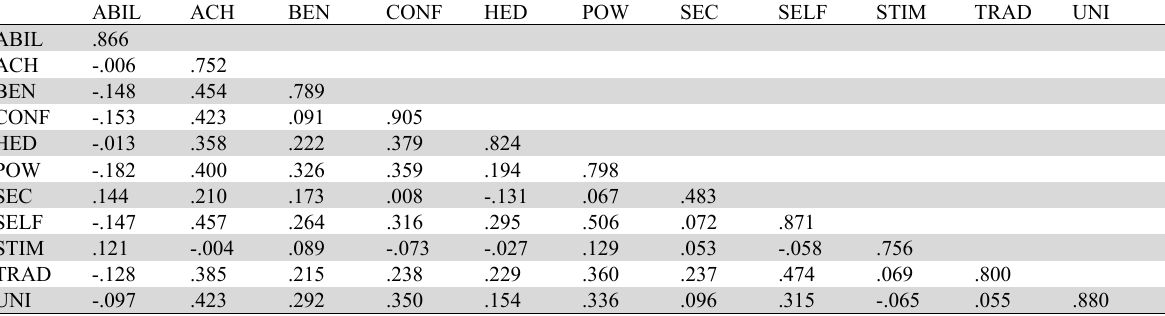
Convergent and discriminant validity of measurements